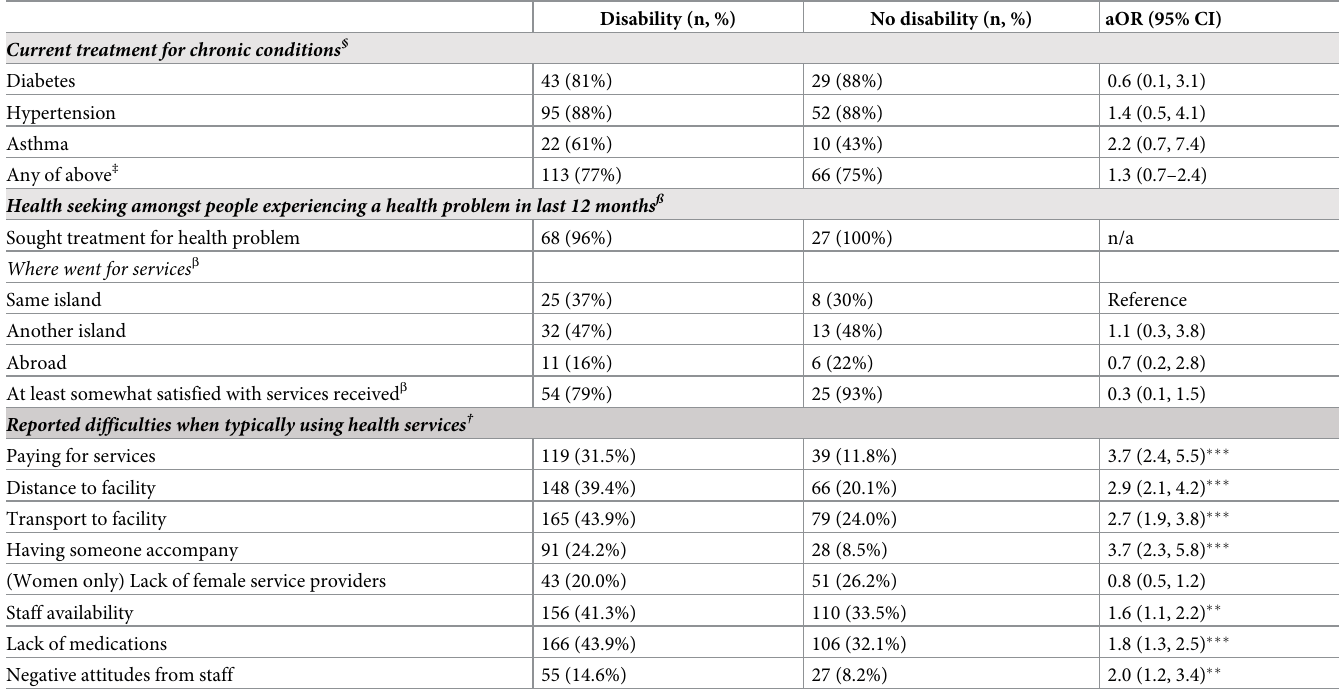
Table 3. Access to general health services amongst people with and without disabilities.